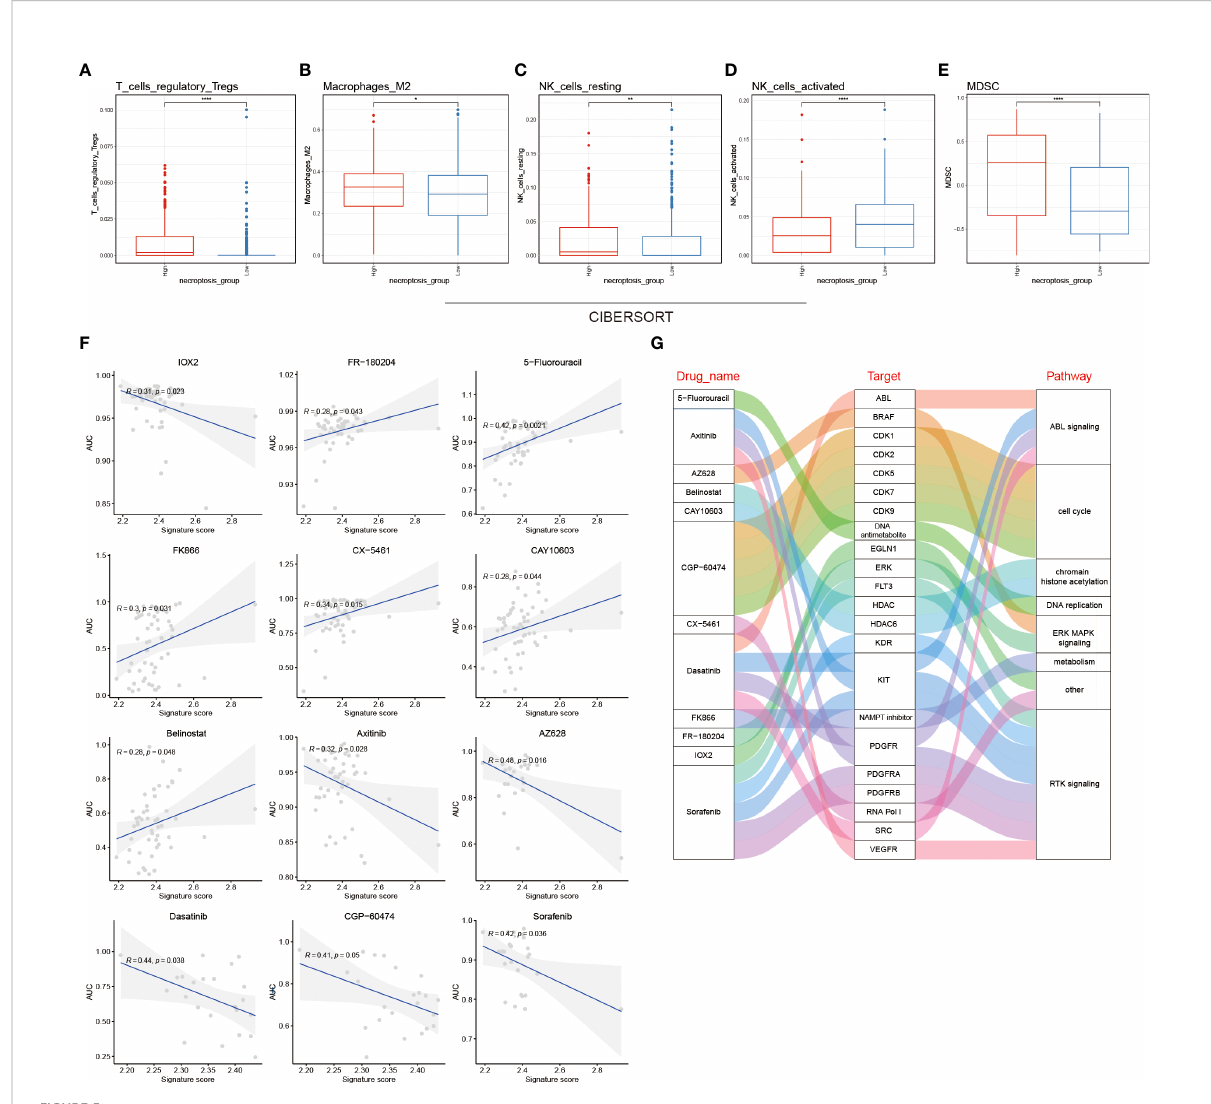
FIGURE 5 Tumor immune cell in fi ltration analysis and chemotherapeutic drug sensitivity between NRS groups. In fi ltration level analysis of Tregs (A) , M2 macrophages (B) , resting NK cells (C) , activated NK cells (D) , and MDSCs (E) between NRS groups by using the CIBERSORT algorithm. (F) Pearson correlation coef fi cient between the AUC of 12 chemotherapy drugs and the signature score in the GDSC database. (G) Sankey plot showing the speci fi c relationship between the 12 drugs in the GDSC database and their target molecules and pathways. * p<0.05; ** p<0.01 and ****